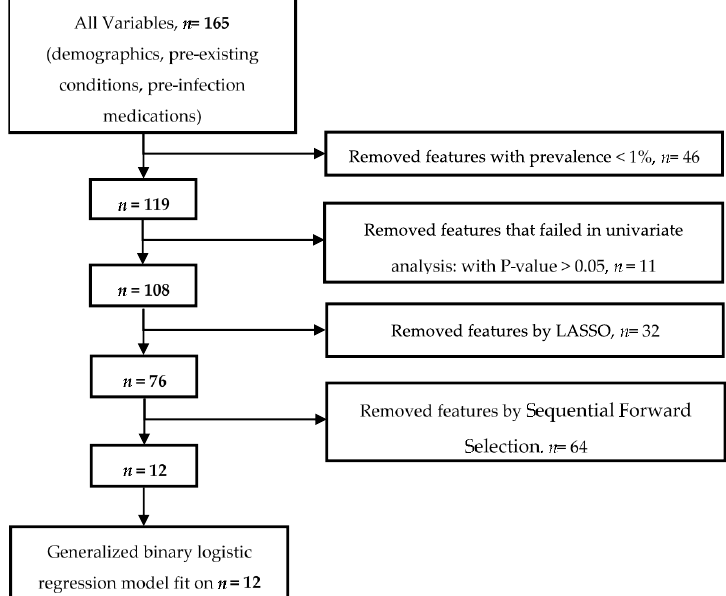
Figure 2. Most important variable selection with a cascade of machine learning